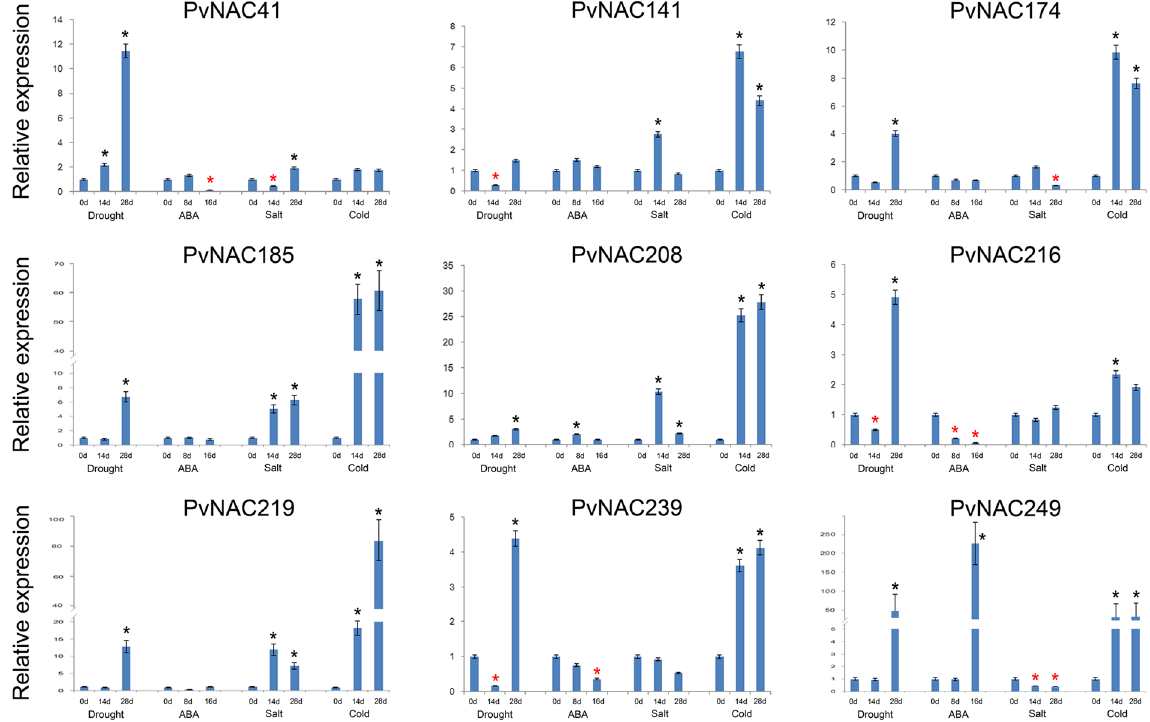
Figure 5. The expression analysis of nine selected PvNAC s relating to ABA and drought, salt, and cold stresses via qRT-PCR. Relative expression of these PvNAC s were normalized in relation to reference gene UCE2 in different stresses. The bars represent error bar. The black * represents the expression for treatment group is more than twice as control group (0 d), while red * represents treatment group is below half of the control group (0